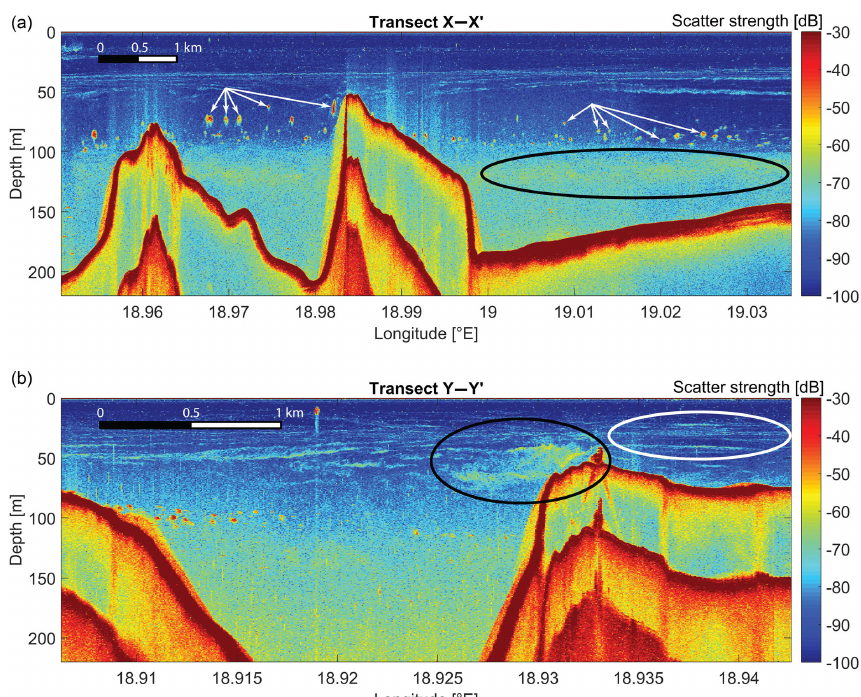
Figure 8. Scatter strength as a function of longitude and depth, from the Kongsberg EK80 split-beam echo sounder (wideband FM mode with centre frequency at 70kHz). (a) The eastern part of the X–X (cid:48) transect shown in Fig. 6c, where examples of fish schools are marked with white arrows and a scattering layer (zooplankton and/or other suspended particles) below 100m depth marked as black ellipse. (b) the Y–Y (cid:48) transect in Fig. 6c, where the white ellipse shows an example of thermohaline stratification and black ellipse an example of turbulent mixing associated with the steep bathymetry. Note how the stratification (thin horizontal lines within the red ellipse) is interrupted by the turbulence, and is only seen intermittently westward of the steep